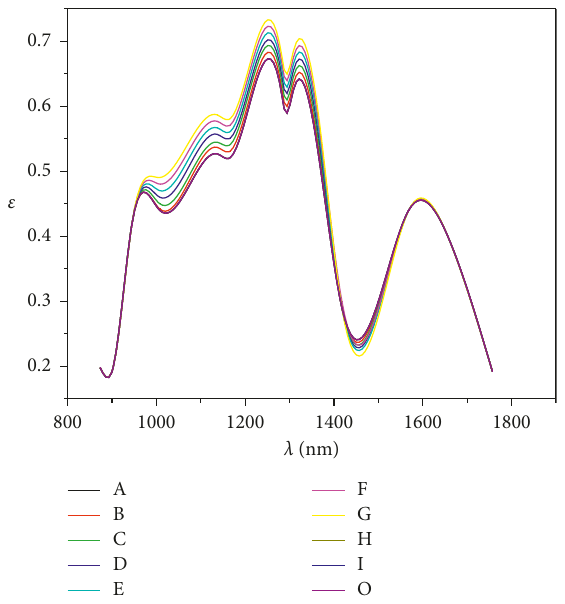
Figure 3: Near-infrared mean reflectance spectrum curve.